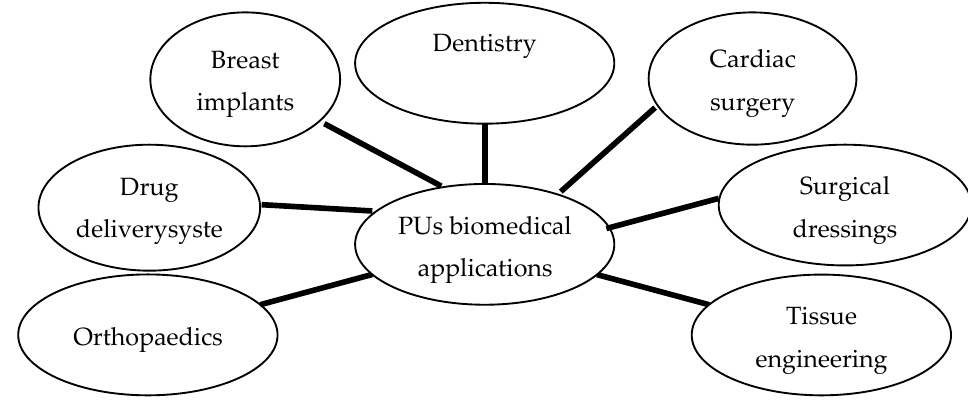
Figure 2. Biomedical applications of PUs.